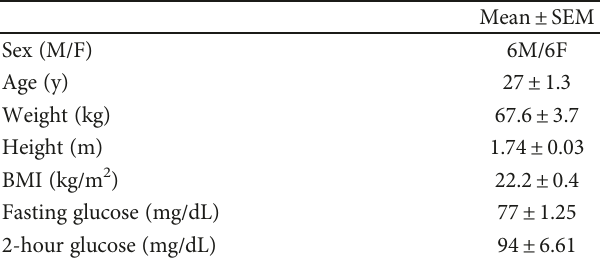
Table 2: Breakfast nutritional facts. Nutritional facts Mean ± SEM